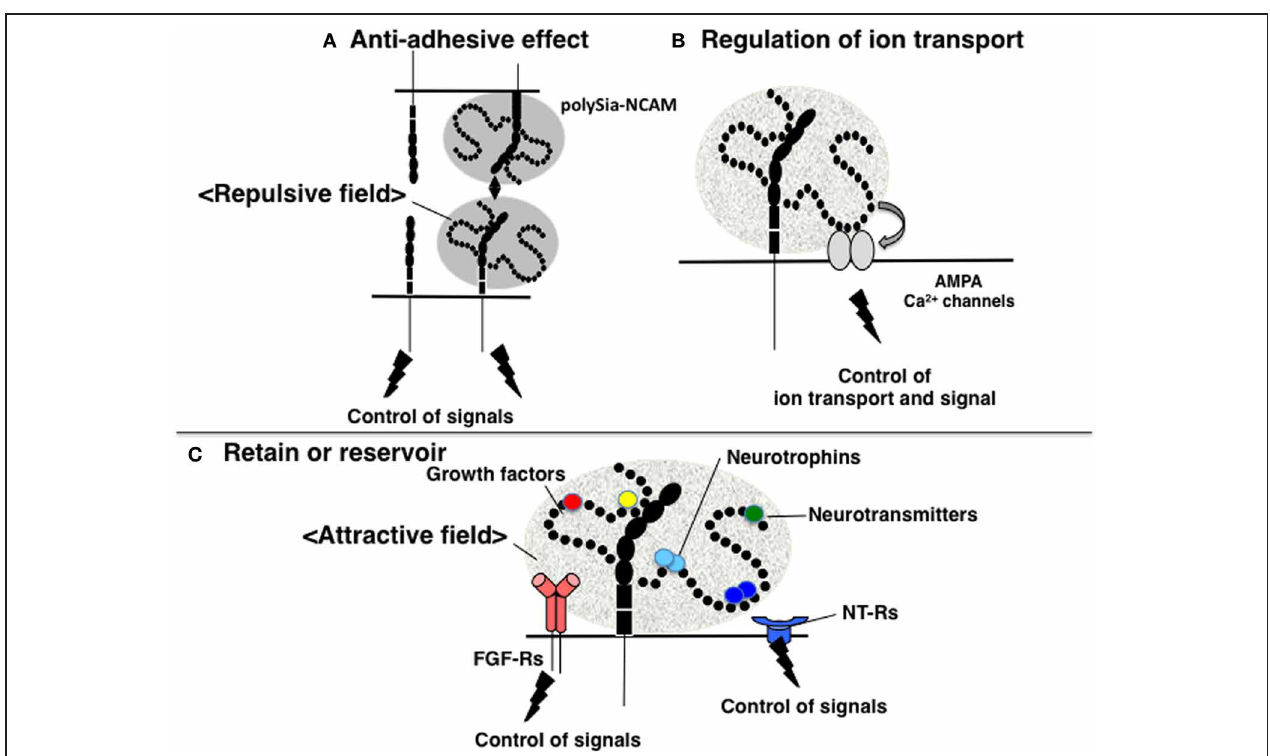
FIGURE 3 | Functions of polySia. (A) Anti-adhesive effect. PolySia-NCAM imparts a repulsive field on the cell surface due to the large volume of polySia (shown in gray) to negatively regulate cell-cell interactions. (B) Regulation of ion transport. The influx and efflux of ions, such as Ca 2 + are regulated by polySia. PolySia on NCAM interacts with Ca 2 + channels, such as AMPA receptors, and regulates their opening and closing, by